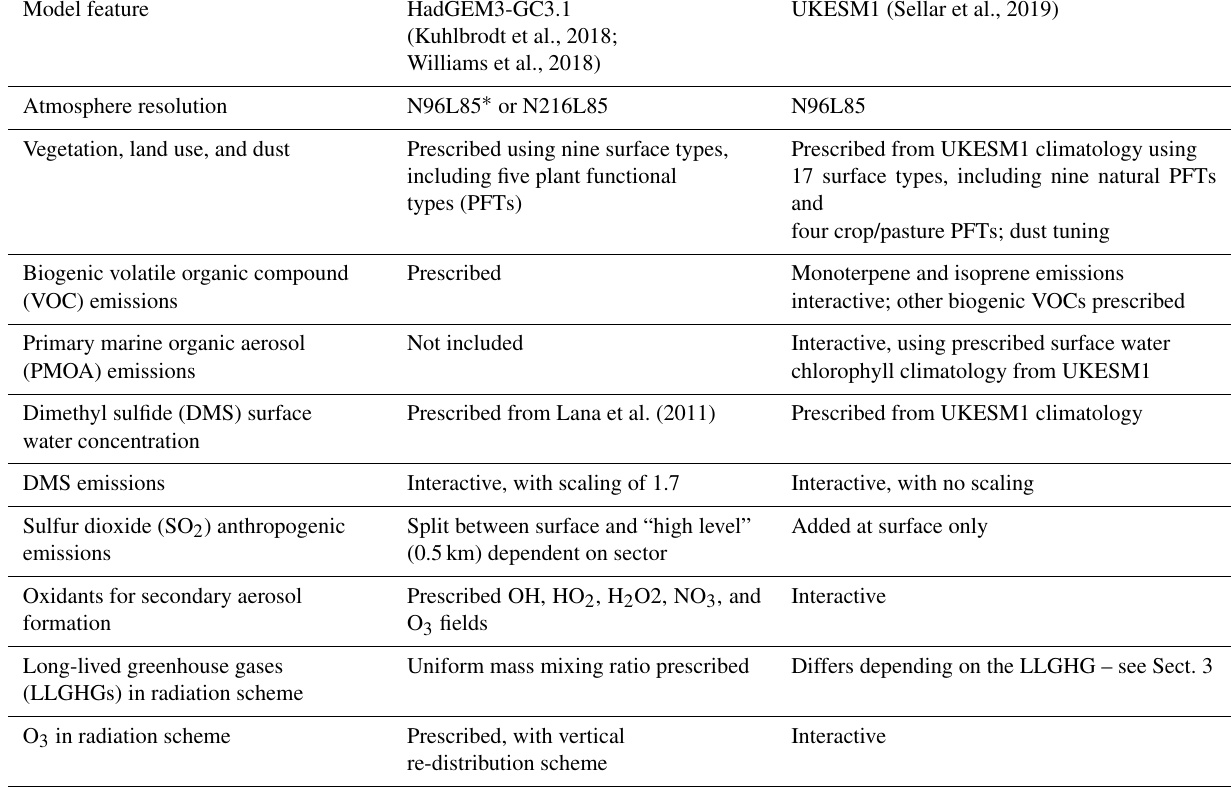
Table A1. Differences between the atmosphere components of the UK’s models for CMIP6: HadGEM3-GC3.1 (called HadGEM3-GA7.1) and